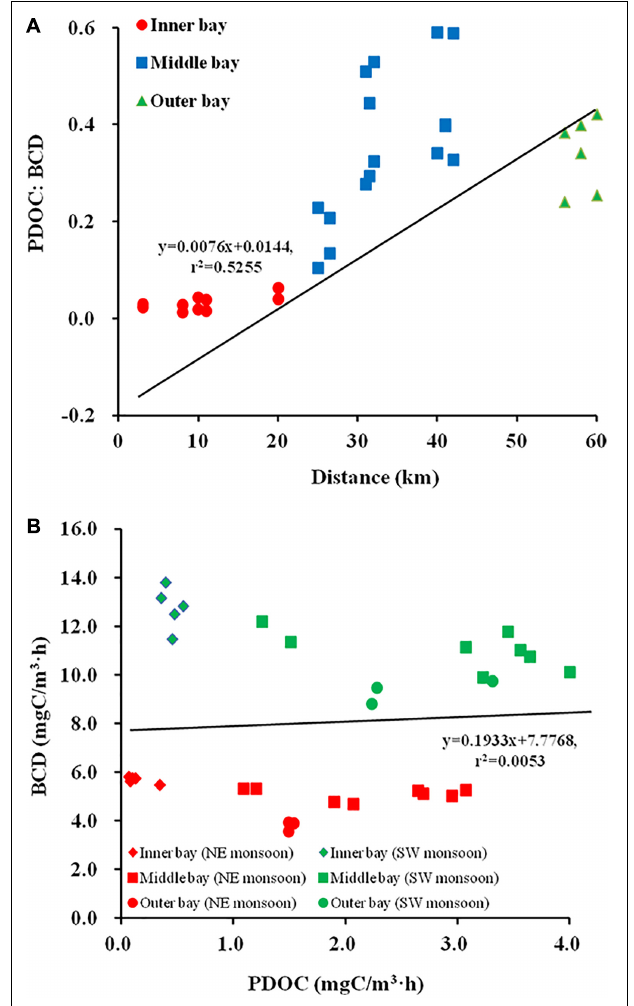
FIGURE 5 | Relationship between PDOC:bacterial carbon demand (BCD) and distance (A) , PDOC and BCD (B) .